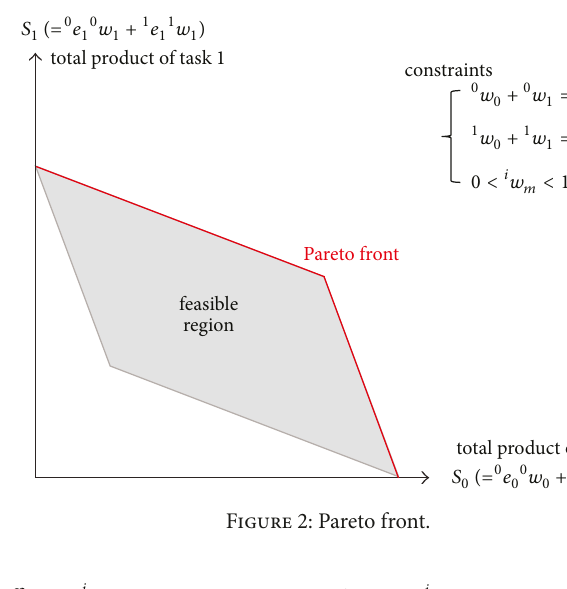
Figure 2: Pareto front.